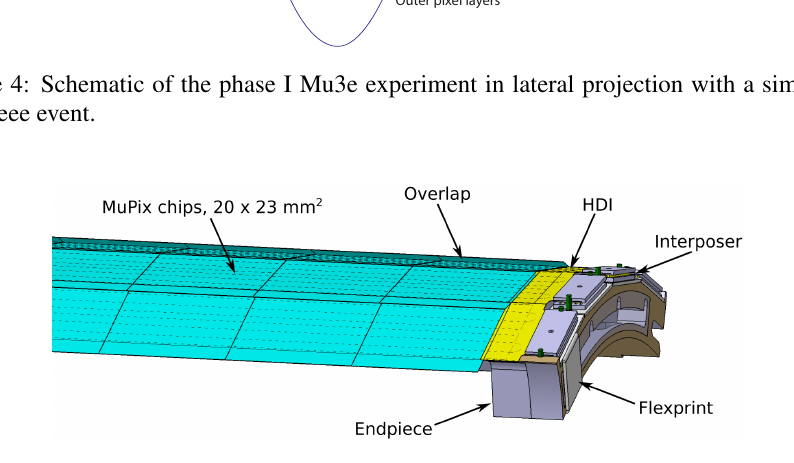
Figure 5: CAD drawing of an outer pixel tracker module: MuPix sensors with a thickness of 50 µ m are glued and spTAB-bonded on High Density Interconnects (HDI), thus forming ladders. The ladders are electrically readout via interposers and flexprints, and